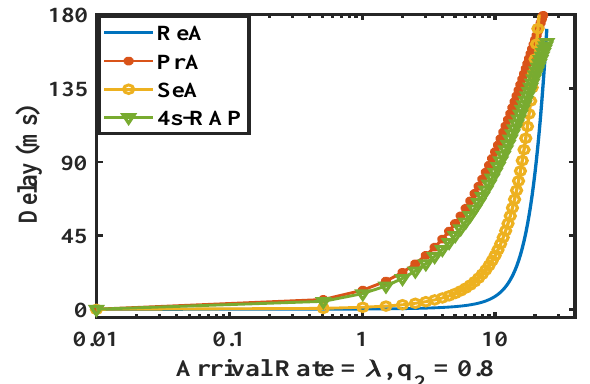
Figure 4. Average delay ( q 2 =